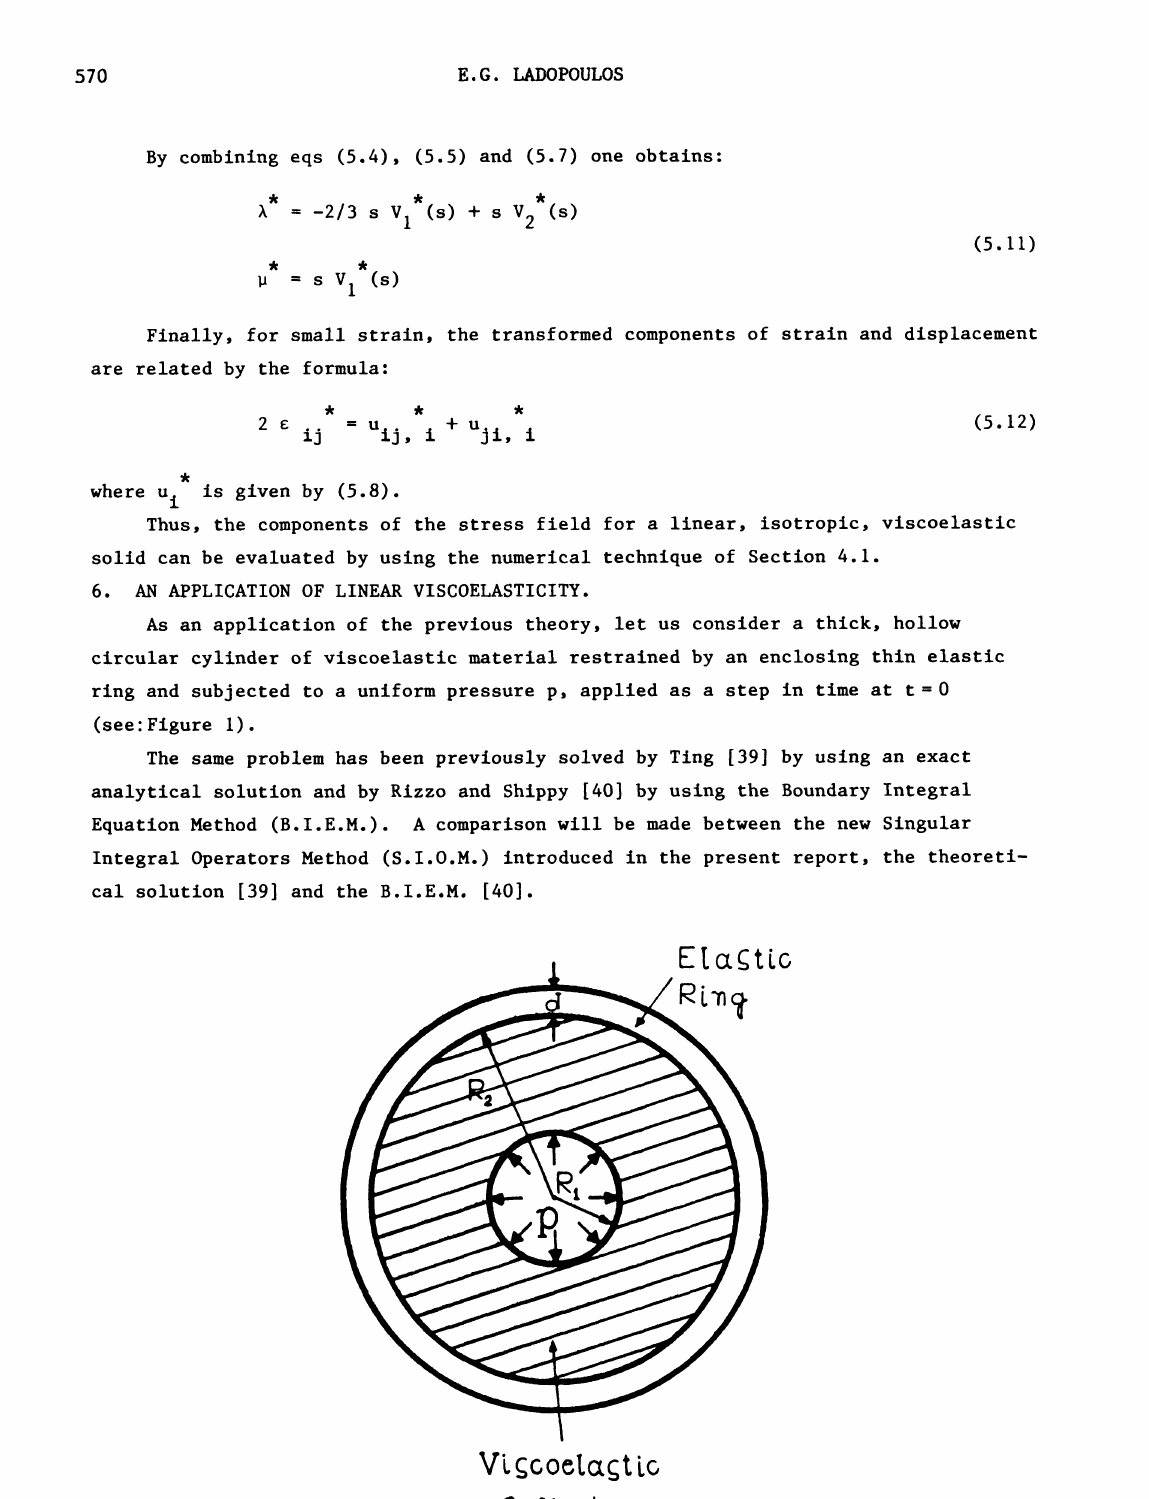
Vt ;c, octc;t Lc, A thick, hollow circular cylinder of viscoelastic solid, Figure I: restrained by an enclosing thin elastic ring and subjected to a uniform pressure